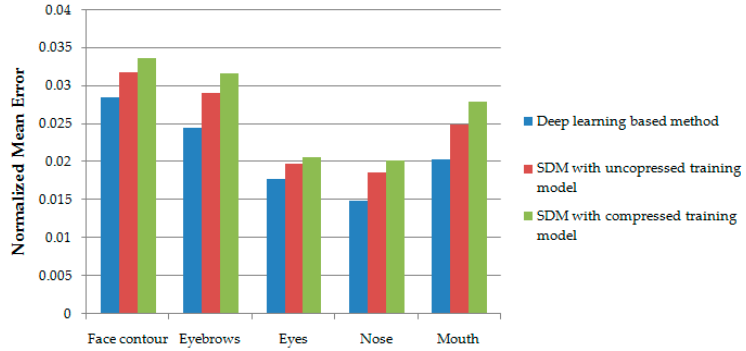
Figure 10. Normalized mean errors of our compressed training model SDM compared with the uncompressed training model SDM [6] and deep learning based method [22] on a subset of the 300 W test dataset [12] whose yaw angles are between 0 and 30 degrees.